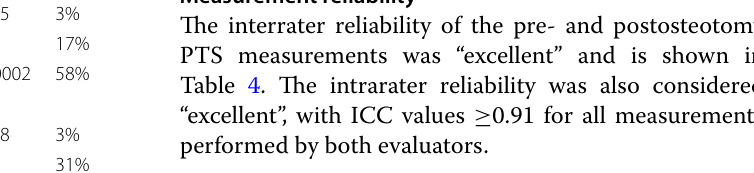
Fig. 5 Preoperative vs postoperative PTS (global 3 & 4 cm, n anteromedial; M, medial; PM, posteromedial